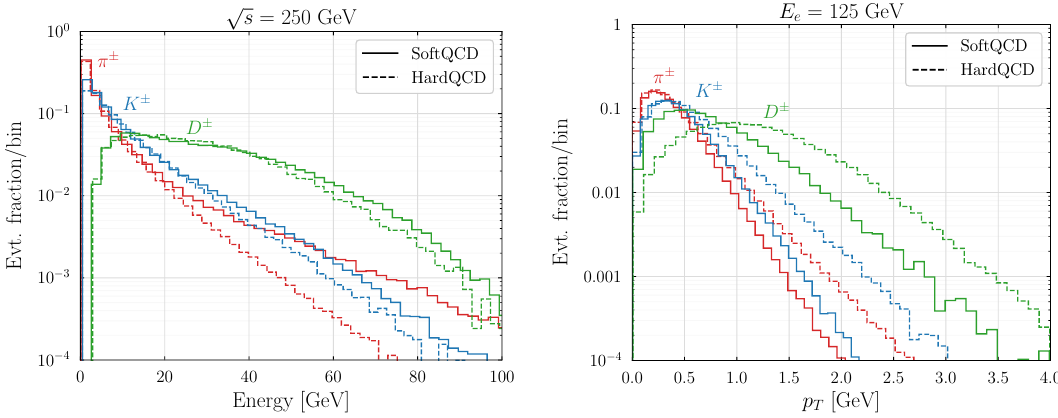
Figure 9 . Energy (left) and p T (right) distributions of mesons produced at an ILC beam dump experiment with an electron beam with energy E = 125 GeV hitting a proton at rest. Events are e generated with Pythia using the SoftQCD event class (solid curves) and the HardQCD event class (dashed curves). The distributions are normalized such that the total bin count sums to